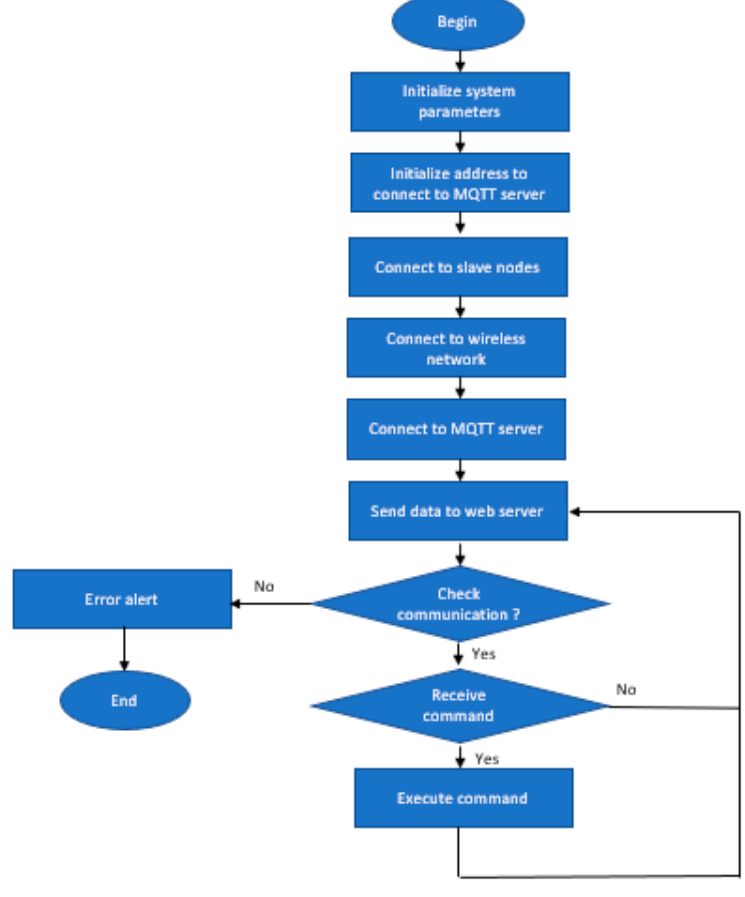
Figure 2. Flowchart of the embedded hardware in the proposed design.